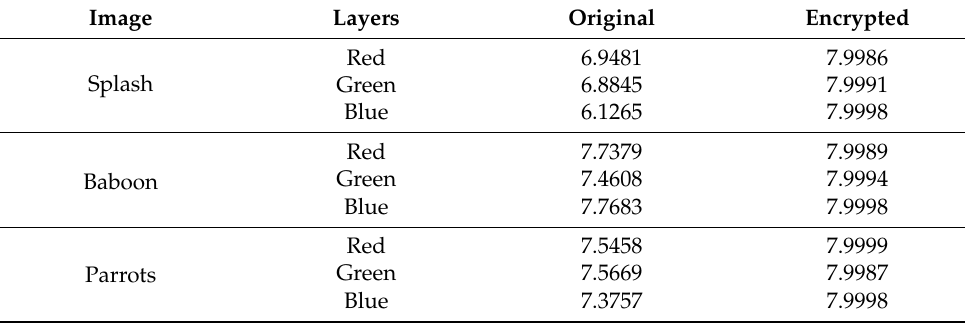
Table 3. Entropy analysis for different standard image